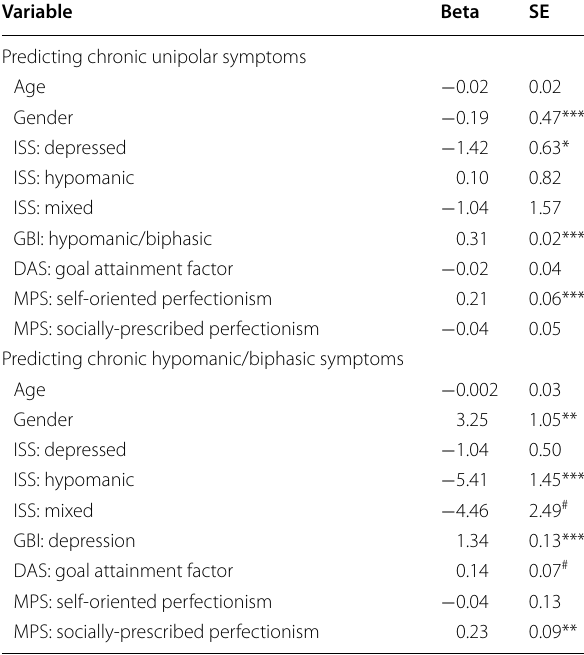
Table 3 Generalized Estimating Equations Using Multi- dimensional Perfectionism Scale Dimensions and